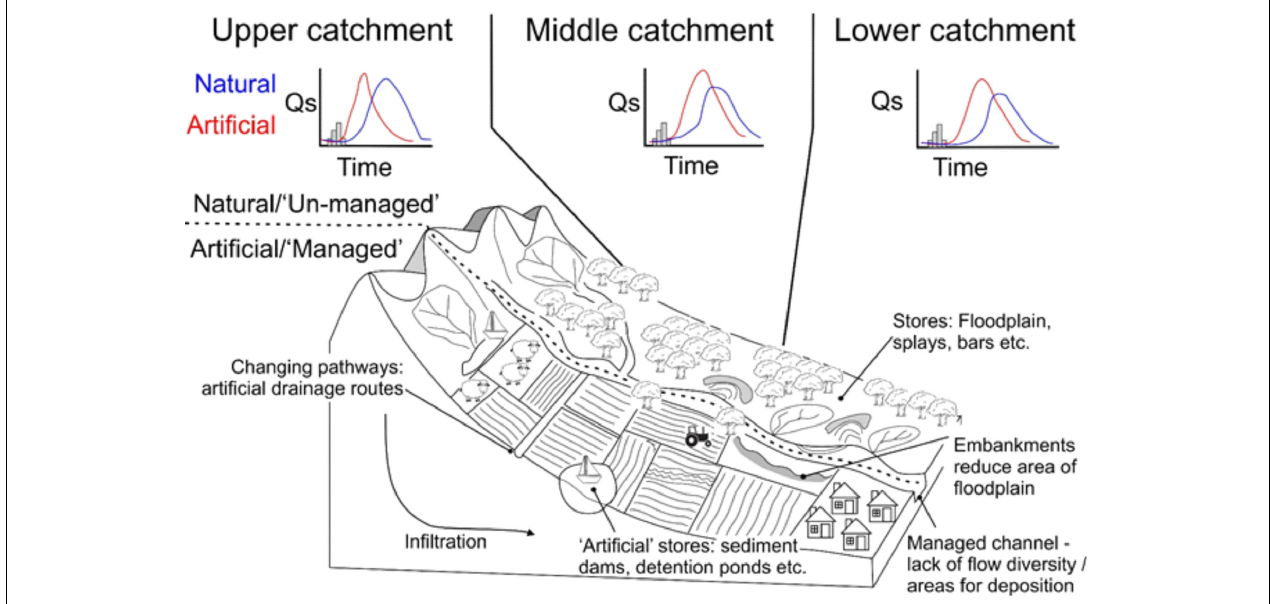
FIGURE 11 | Synthesis figure showing the influence of anthropogenic (a ‘managed catchment’) activity on source to sink.